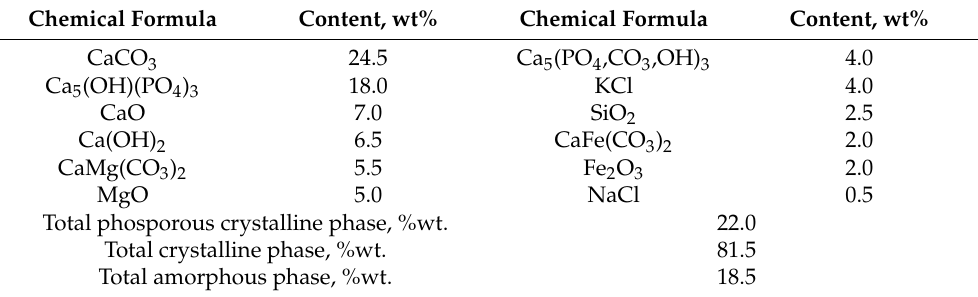
Table 5. Phase composition of ash (sample